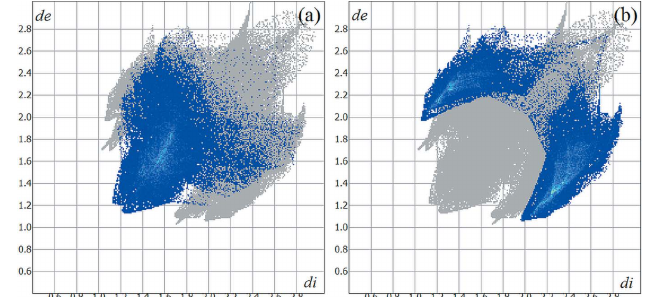
Figure 5 Hirshfeld surface fingerprint plot for the title compound showing ( a ) the H (cid:2)(cid:2)(cid:2) H and ( b ) the H (cid:2)(cid:2)(cid:2) I contacts in detail (cyan dots). The contribution of the these intermolecular interactions to the crystal packing amounts to 31.40 and 34.60%, respectively.